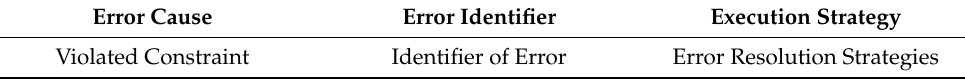
table and executes the strategy. Table 5 shows the strategy execution table. Table 5. Strategy execution